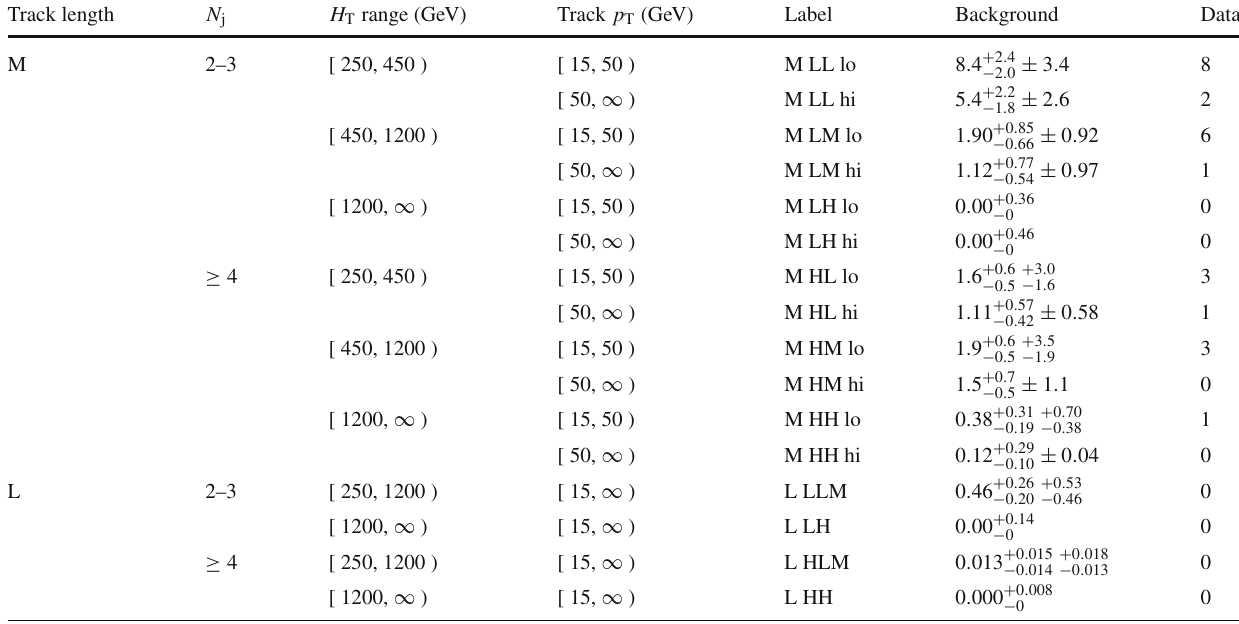
Table 26 Summary of the 16 signal regions of the search for disappear- ing tracks for medium (M) length and long (L) tracks, for the 2017– 2018 data set, together with the corresponding background predictions and observations. For the background predictions, the first uncertainty